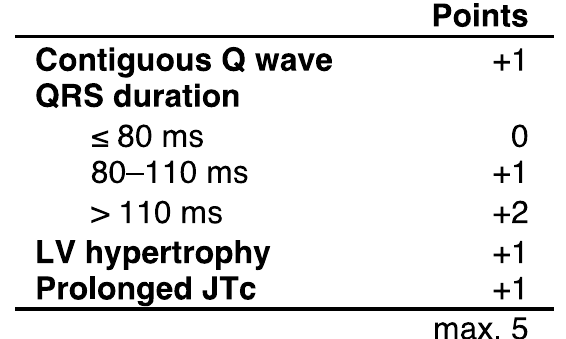
Figure 1. Composition of the ECG score. The table shows the composition of the ECG score devel- oped by Chatterjee et al. [19].